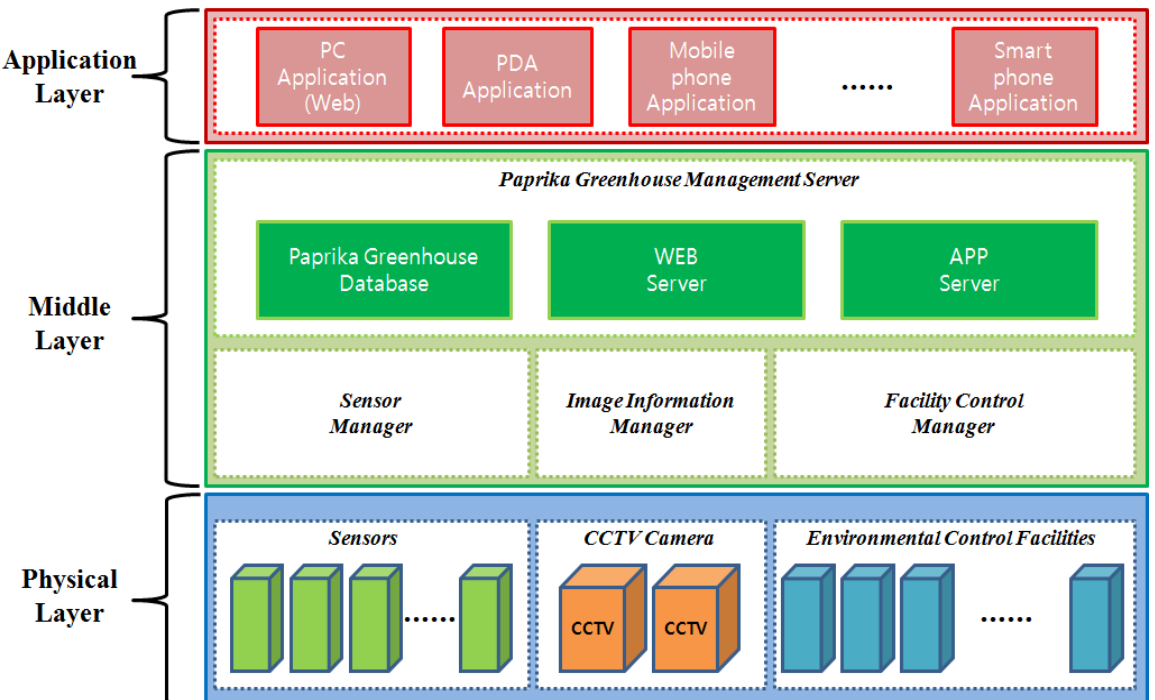
Figure 1. Paprika Growth Management System